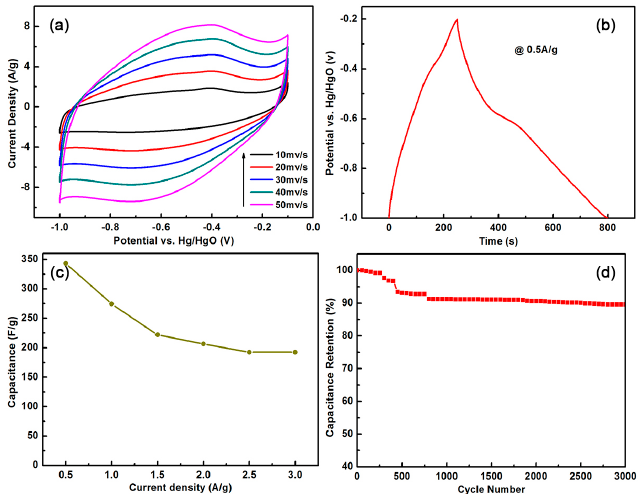
Figure 5. Cyclic voltammetry (CV) curves of thin BCN sheets in 6 M KOH solution at scan rates of 10, 20, 30, 40, and 50 mV/s ( a ); Galvanostatic charge/discharge curves at a current density of 0.5 A/g ( b ); corresponding capacity retention at the current density from 0.5 to 3 A/g ( c ); and, Stability evolution of BCN samples at a current density of 8 A/g in 6 M KOH solution ( d ).